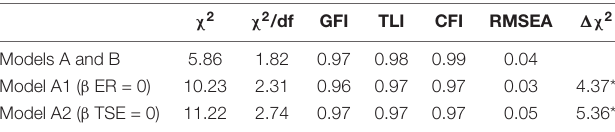
TABLE 3 | Goodness of fit